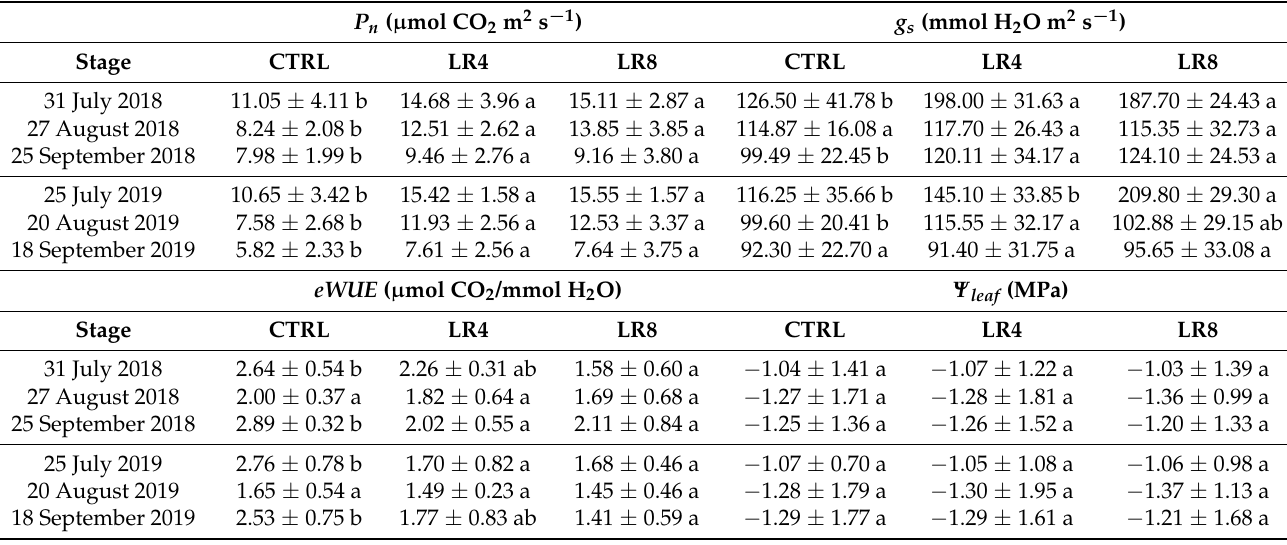
Table 2. Physiological parameters. Net photosynthesis ( P n ), stomatal conductance ( g s ), water use efficiency ( eWUE ) and leaf water potential ( Ψ leaf ) of V. vinifera treated with three different defoliation management methods: four leaf removal (LR4), eight leaf removal (LR8), and no defoliation (CTRL). Measurements were conducted at full veraison, mid-maturation and full maturation. Data (mean ± SE, n = 10) were subjected to one-way ANOVA. Different letters within the same parameter and row indicate significant differences (LSD test, p ≤ 0.05).